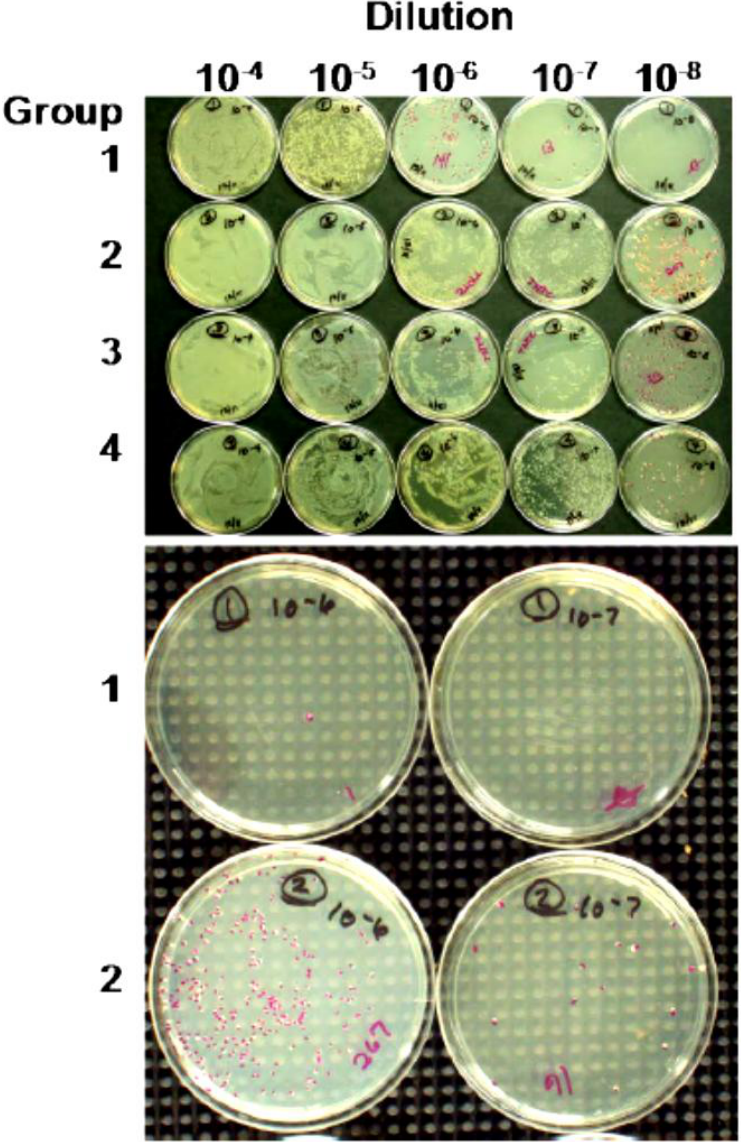
Figure 3. Spread plates from an anti- E. coli O111 lipopolysaccharide (LPS) aptamer-C1q killing experiment [11]. The “antibiotic” effect due to aptamer-C1q triggering of the complement system is especially visible in the lower panel where the full test Group 1 shows few, if any, colonies while control Group 2 shows a noteworthy number of colonies across the same two dilutions. The compositions of each group were as follows: Group 1-full test group with aptamer-C1q conjugate and all other complement components. Group 2-control group for the alternative pathway which contained no aptamer-C1q and simply assessed bacterial colony counts in the presence of human serum. Group 3- was a positive growth control group with no serum or aptamer-C1q added. Group 4- contained bacteria treated only with the aptamer-C1q conjugate, but may have triggered some bacterial killing due to contaminating traces of other complement or serum proteins. Ten-fold serial dilutions are shown across the top of the top panel. The bottom panel shows only the 10 −6 and 10 −7 dilutions for Groups 1 and 2 from a second